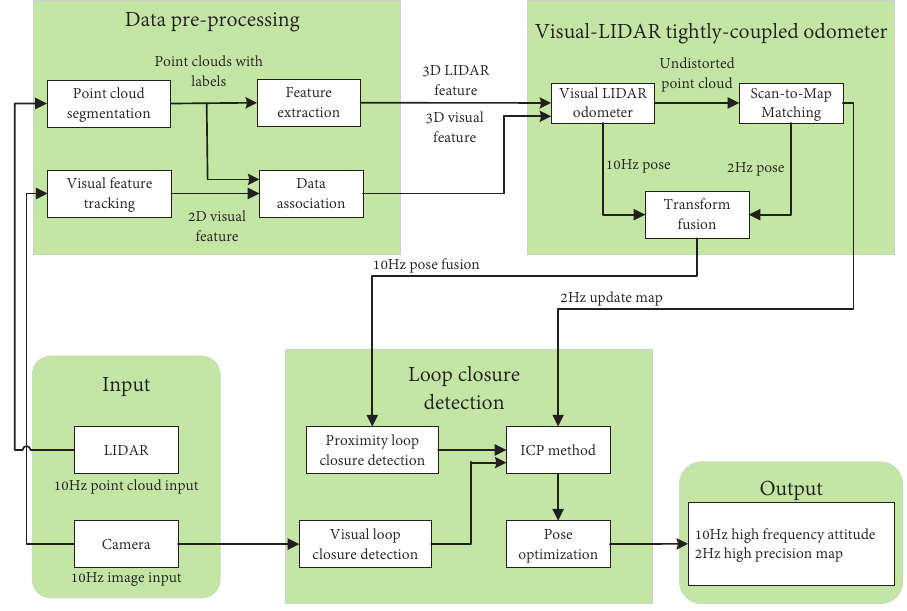
Figure 21. Frame diagram of tightly coupled multi-sensor fusion. The system receives a visual image of the same frequency as the LIDAR point cloud. Then, in the data preprocessing phase, 2D image features are tracked and extracted for the point cloud segmentation and feature extraction, respectively. After the 3D LIDAR characteristics and data correlations of the 3D visual characteristics are fed into the tightly coupled LIDAR speedometer, scanning is carried out to further refine the map matching. After fusion and transformation, the pose and map obtained are imported into the loop closure detection module. The ICP method is used to perform global pose map optimization, and a high-precision map and high-frequency pose estimation are finally